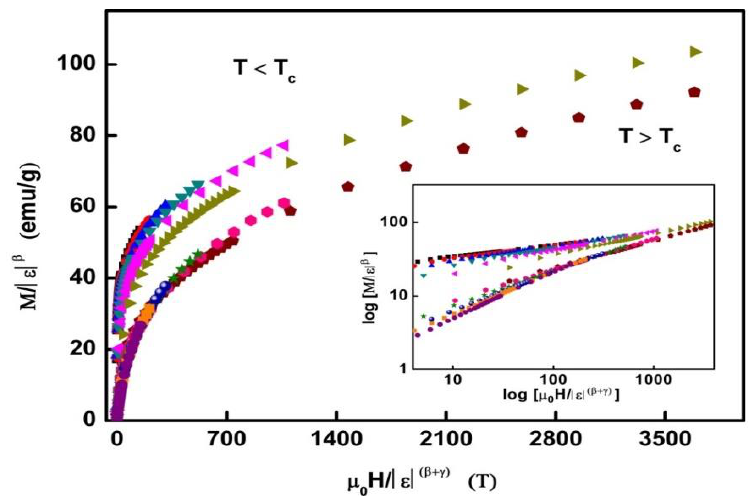
Figure 12. Scaling plots (following the procedure described in ref. [28] where the points correspond to regular analytical functions) indicating universal curves above and below 𝑇 𝑐𝐴 . The inset shows the same plot in log – log scale. Table 2. Comparison of estimated critical exponents of Ni 51.82 Mn 32.37 In 15.81 ribbons with other reports and the various theoretical